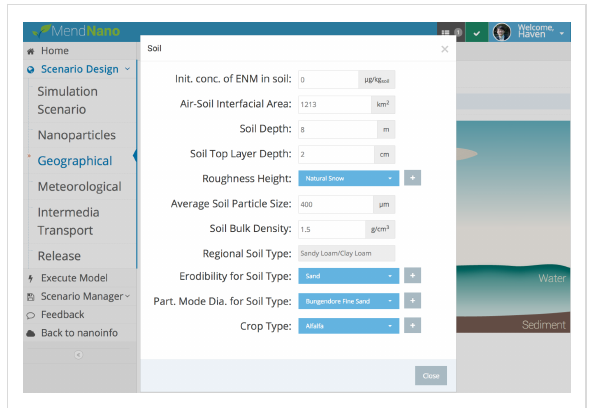
Figure 7: Examples of MendNano web-based graphical user interface for scenario building showing inputs of soil parameters.